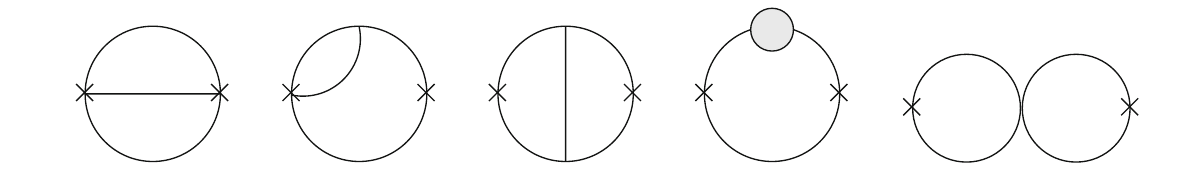
Fig. 4 2-Loop contribution to the (cid:2) TT (cid:3) . The blob in the fourth diagram represents an insertion of a 1-loop